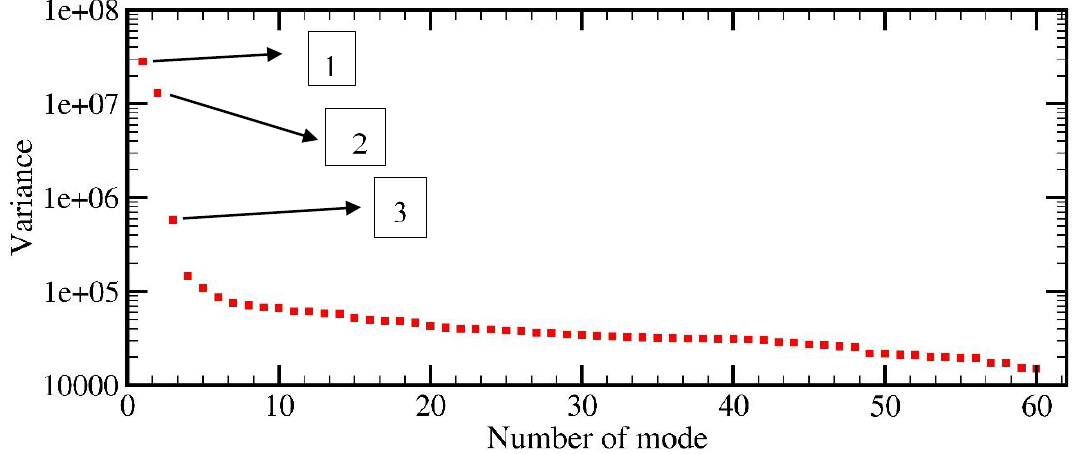
Figure 7. Singular values spectrum of data with a window size of 60 images showing three modes (note: the vertical axis shows the log-transformed variance of three modes).